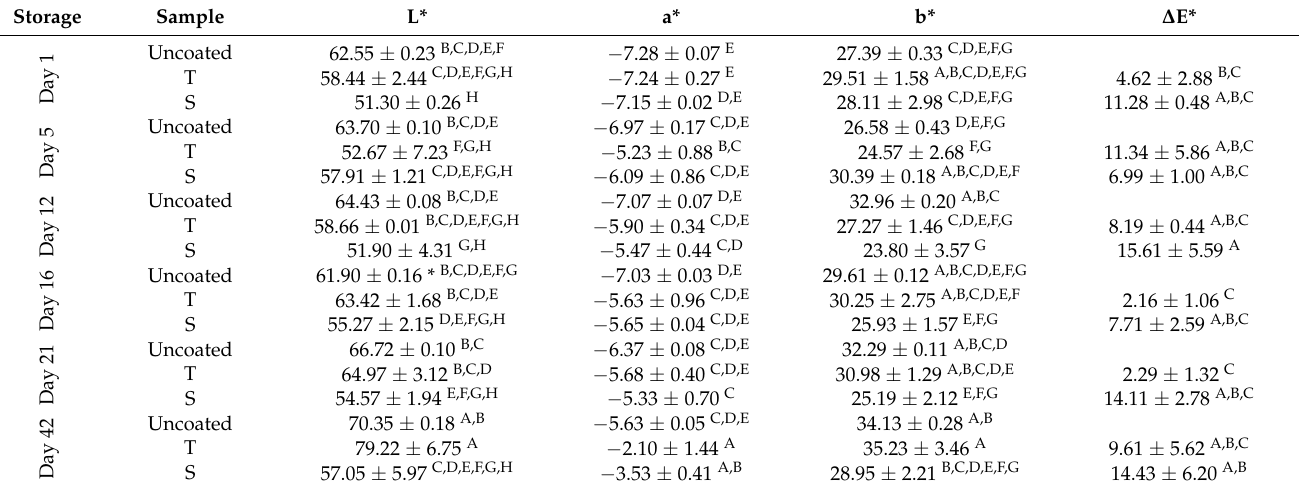
Table 3. Color evaluation of zucchini peel during 42 days of storage.